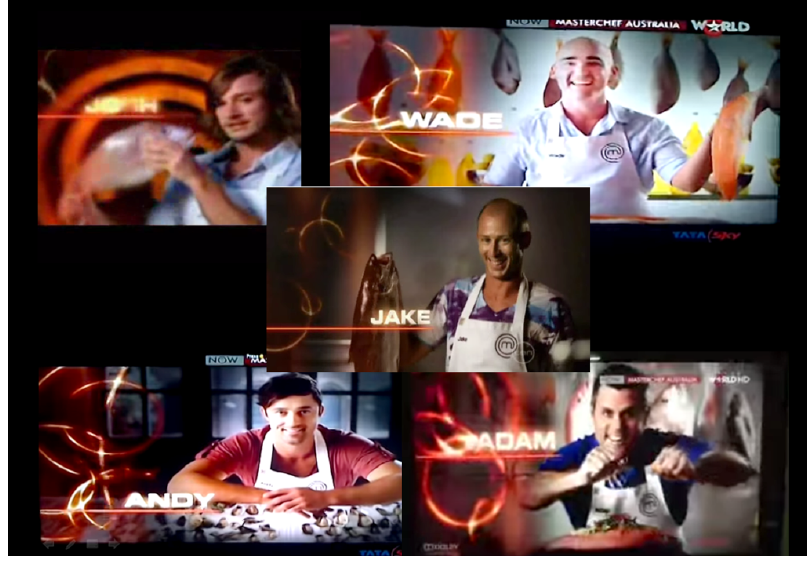
Figure 4. Male contestants holding or presenting raw seafood in introduction